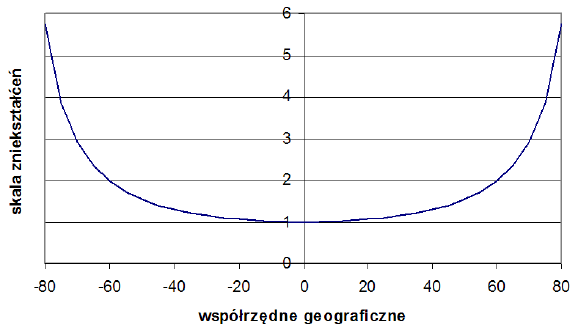
Fig. 8. A graph of the scale of distortions in the Mercator